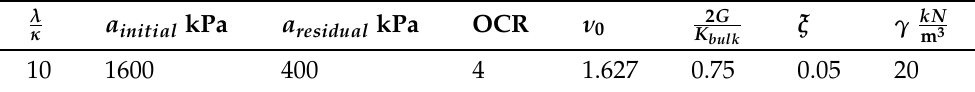
Table 2. Deterministic parameters of the soil